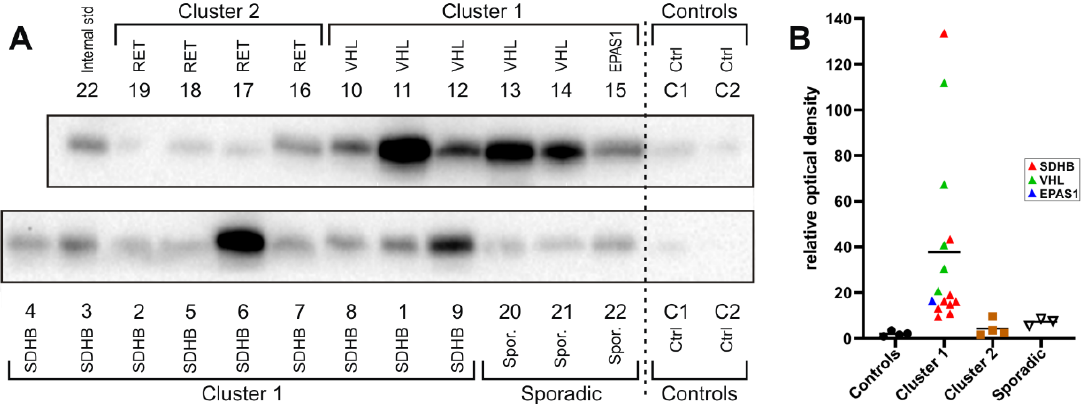
Figure 4. Western blot and densitometry of PSMA signal. ( A ) Western blots of all 22 tumor samples and 2 controls (pooled adrenal medulla). Lysate samples, each representing 30 micrograms of protein, were loaded. To normalize the PSMA signal intensity between the 2 membranes, sample 22 was present on both membranes and used as an internal standard. Loading control: Due to heterogeneity of tumors and individuals, standard loading control based on “housekeeping” proteins (GAPDH, Tubulin, Actin) could not be used, as their antibody-detected levels varied significantly among the individual samples. To solve this problem, we ran each gel in duplicate; one gel was used for Western blotting and the second was stained by Coomassie Brilliant Blue (CBB), and the total optical density was determined for each lane to ensure equal protein loading. ( B ) Normalized optical densities of the PSMA signal from the Western blots are plotted for individual samples being divided according to the respective PPGL clusters (Controls, Cluster 1, Cluster 2, Sporadic). Colors indicate the underlying mutated genes in Cluster 1 PPGLs.